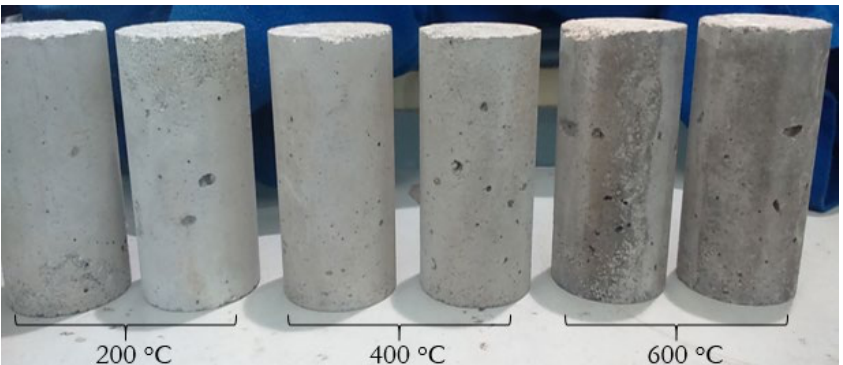
Figure 3. Changes of color of plain concrete specimens exposed to temperatures of 200, 400 and 600 ºC.